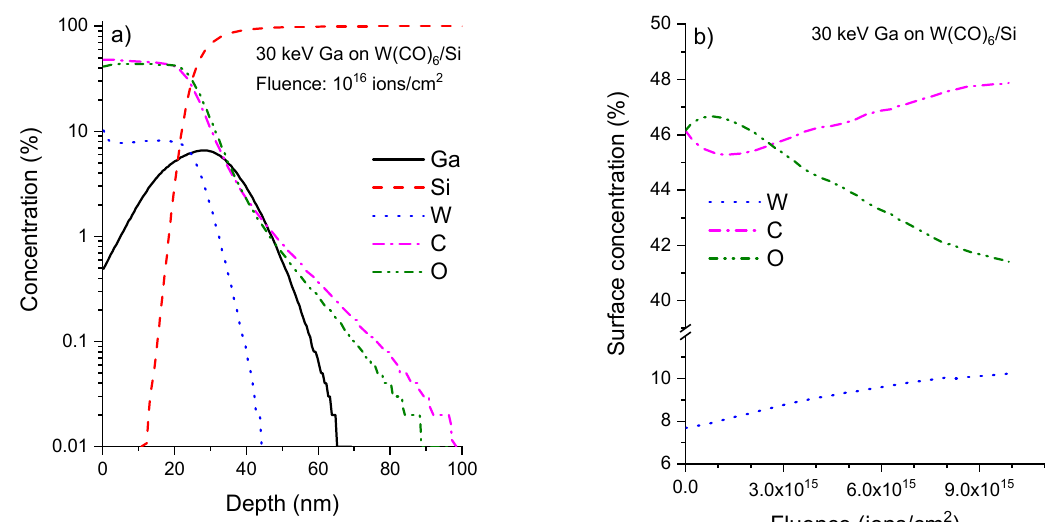
Figure A1. ( a ) Theoretical composition as a function of depth for Cryo-FIBID W-C deposits according to the calculations reported in the main text for a fluence of 1 × 10 16 ions / cm 2 ; ( b ) Surface composition as a function of fluence for the same modelling conditions than for ( a).